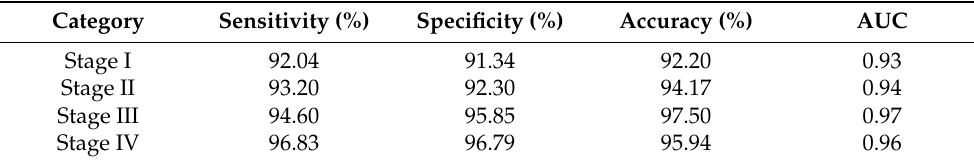
Table 8. The performance of CNN models in four NSCLC stages.